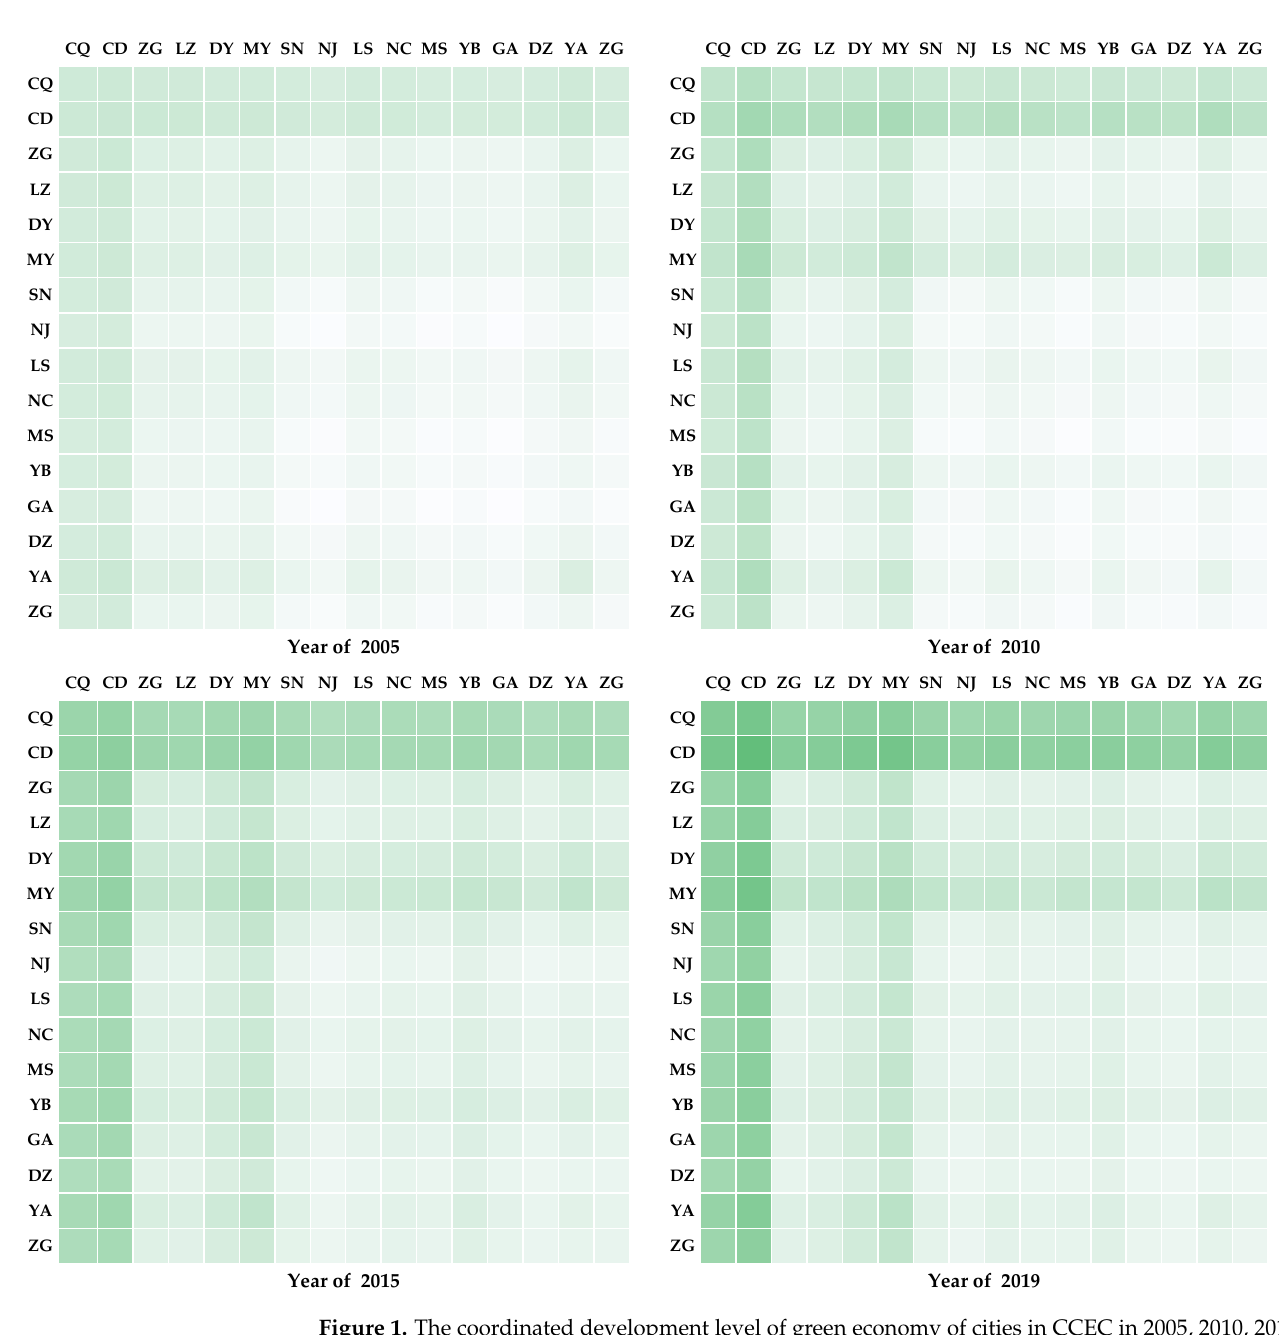
Figure 1. The coordinated development level of green economy of cities in CCEC in 2005, 2010, 2015, and 2019.